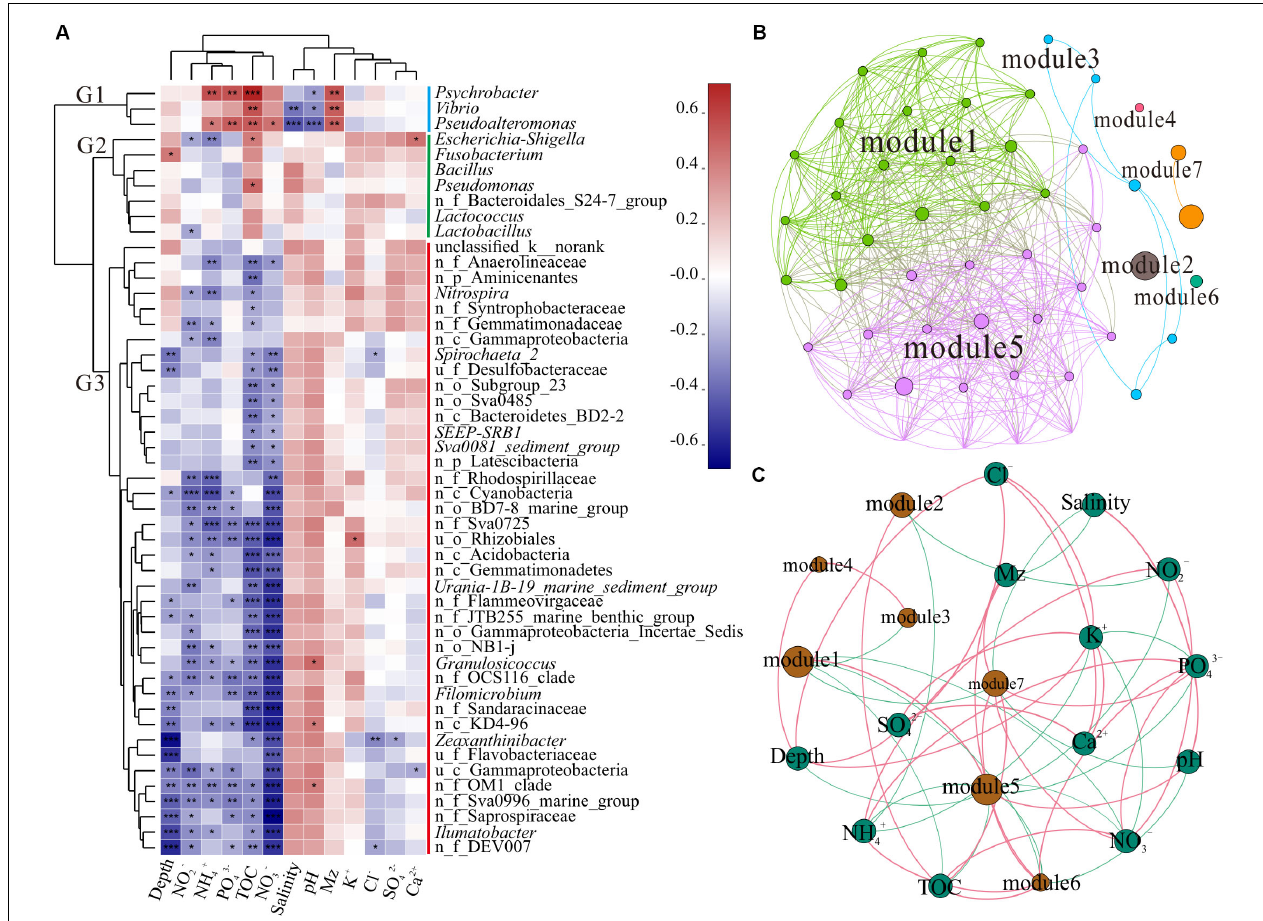
FIGURE 3 | Correlation analysis. (A) Correlation heatmap between the top 50 genera and environmental factors. Clusters based on environmental factors are above the heatmap and clusters of genera are on the left of the heatmap; n_ and u_ indicate no rank and unclassified, respectively. The asterisks in the cell represent significant correlation, * p < 0.05, ** p < 0.01, and *** p < 0.001. The values denote correlation coefficient. (B) Network of the top 50 genera. Top 50 abundant genera in all 39 samples were selected to calculate the correlation among bacteria. Each node represents a genus, the nodes are colored by module, and the connection between the nodes represents a significant correlation (Spearman, p < 0.05, r > 0.6). (C) Network of the correlation between modules and environmental factors (Spearman, p < 0.05, r > 0.3) across all 39 samples. The sum of all bacterial abundances in the module represents the richness of the module. Brown nodes represent the modules of the microbiome, and the sizes of the brown nodes indicate the relative abundance of the bacteria. Green nodes represent environmental factors. Red edge represents positive correlation and green edge denotes negative correlation.